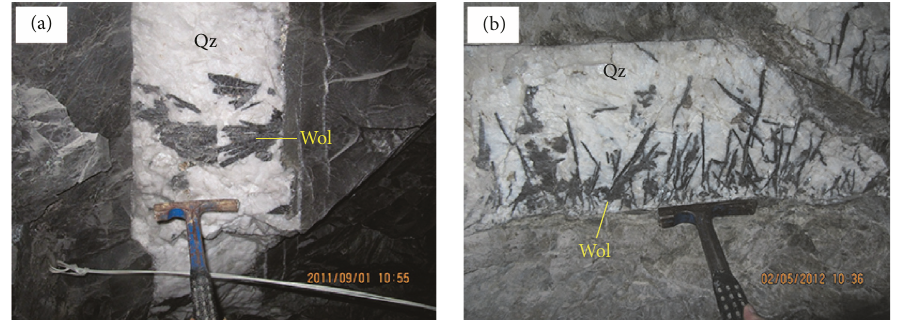
Figure 1: Photos of wolframite-quartz veins at two tungsten deposits in the Nanling Range. (a) Tabular wolframite has grown symmetrically normalto thewalls of athick vein at theDajishan deposit [28].View toupwards. (b)Needle-like wolframitecrystallizes normaltothewallrock at the Piaotang deposit. View to upwards. Qz, quartz; Wol,